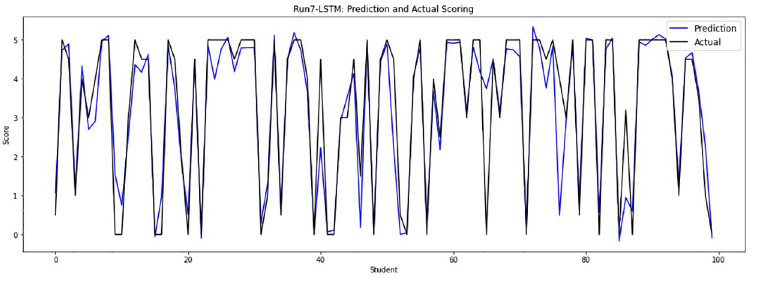
Fig 12. LSTM-GWO prediction and actual scores with experiment 7.